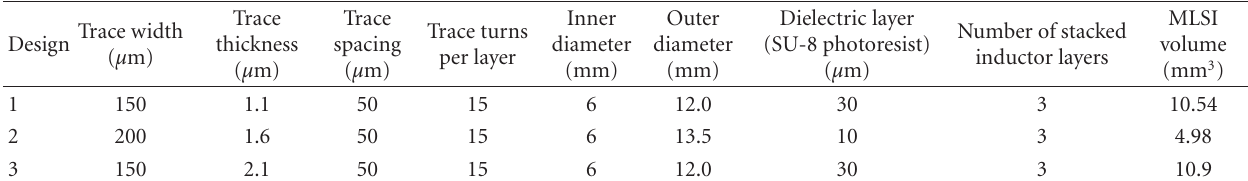
Table 1: MLSI geometric variations.